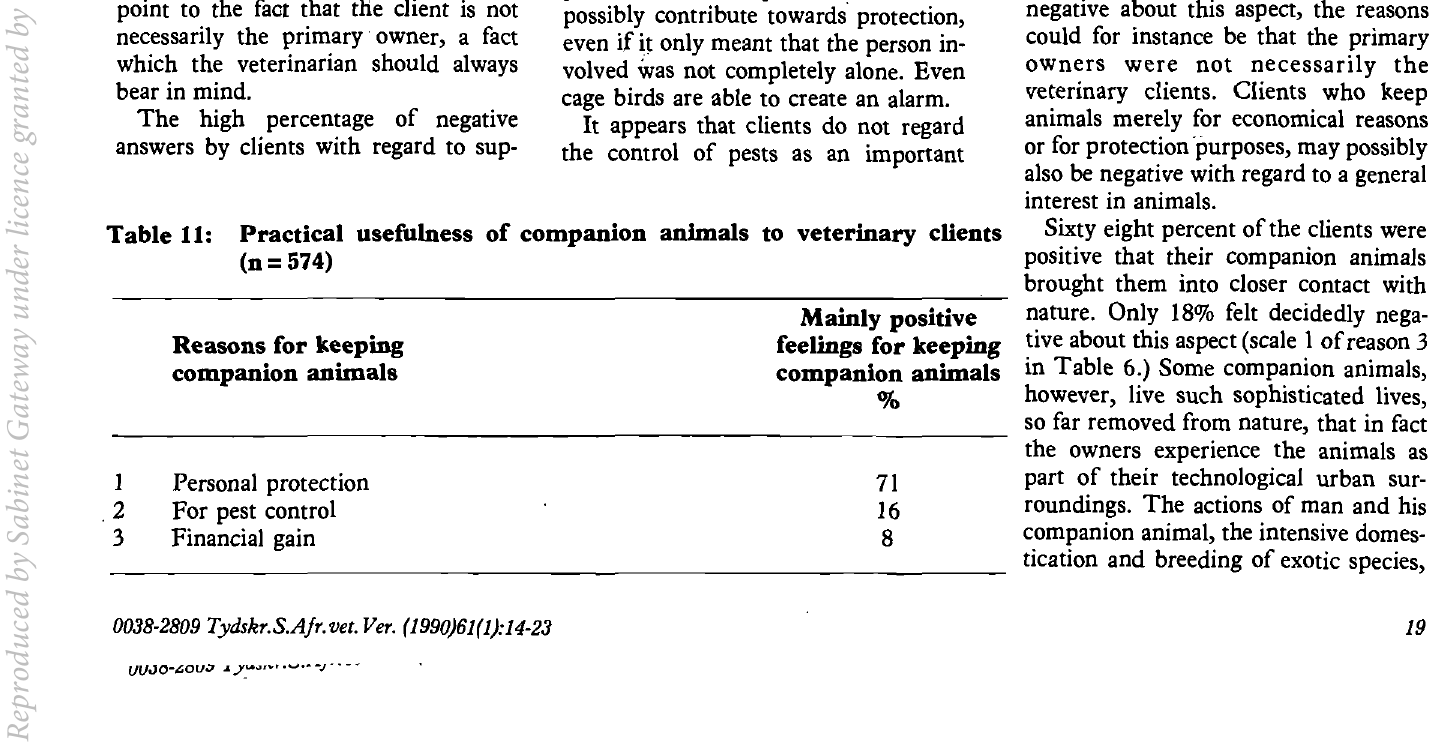
Practical usefulness of companion animals to veterinary